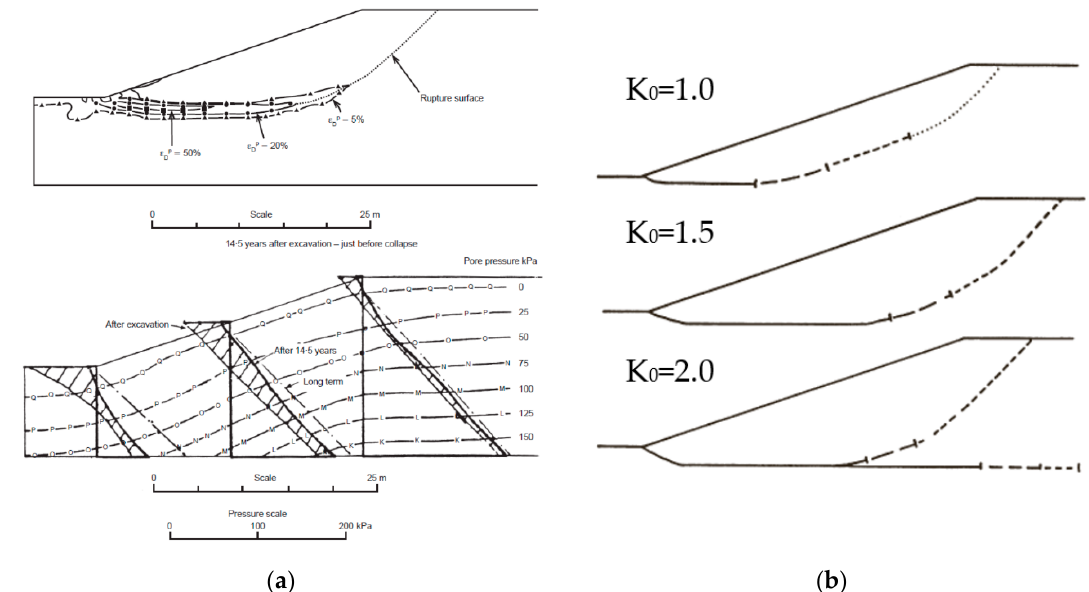
Figure 12. Coupled hydro-mechanical numerical modelling of the effects with time of the slope excavation in London clay: results of numerical FE analyses with negative hardening ( a ) and effect of K 0 on the shape of the predicted shear band (( b ); [5]).